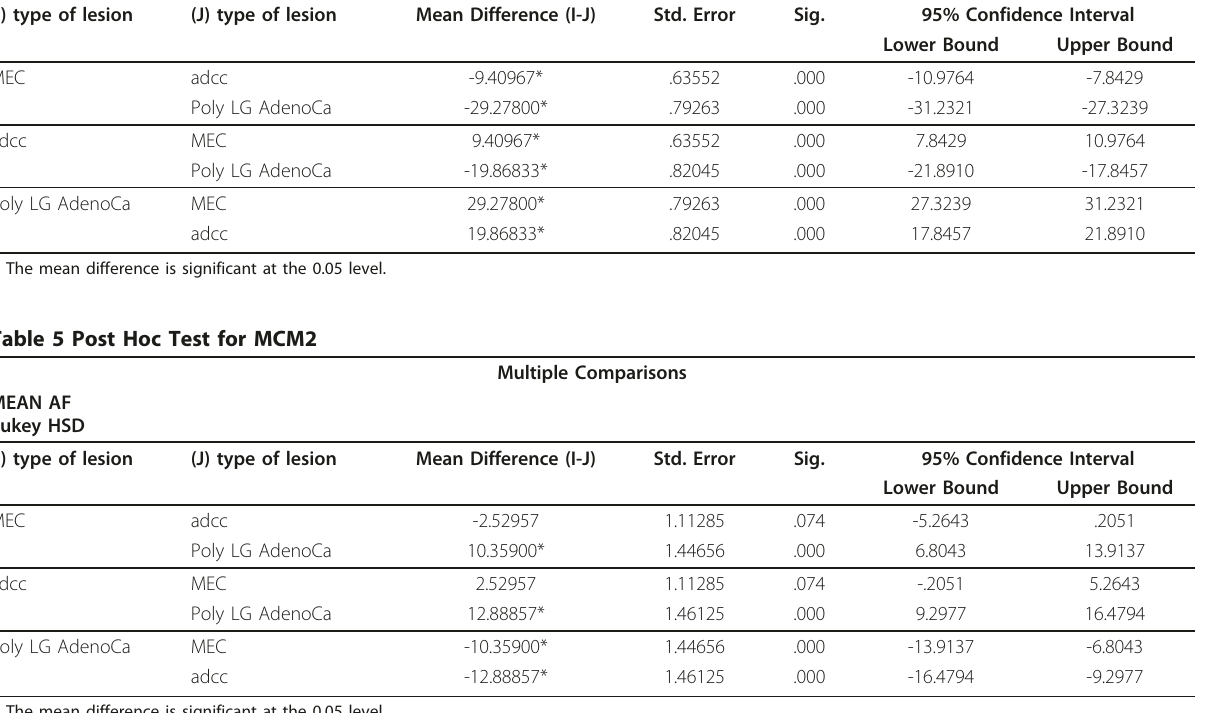
Table 4 Post Hoc Test for maspin